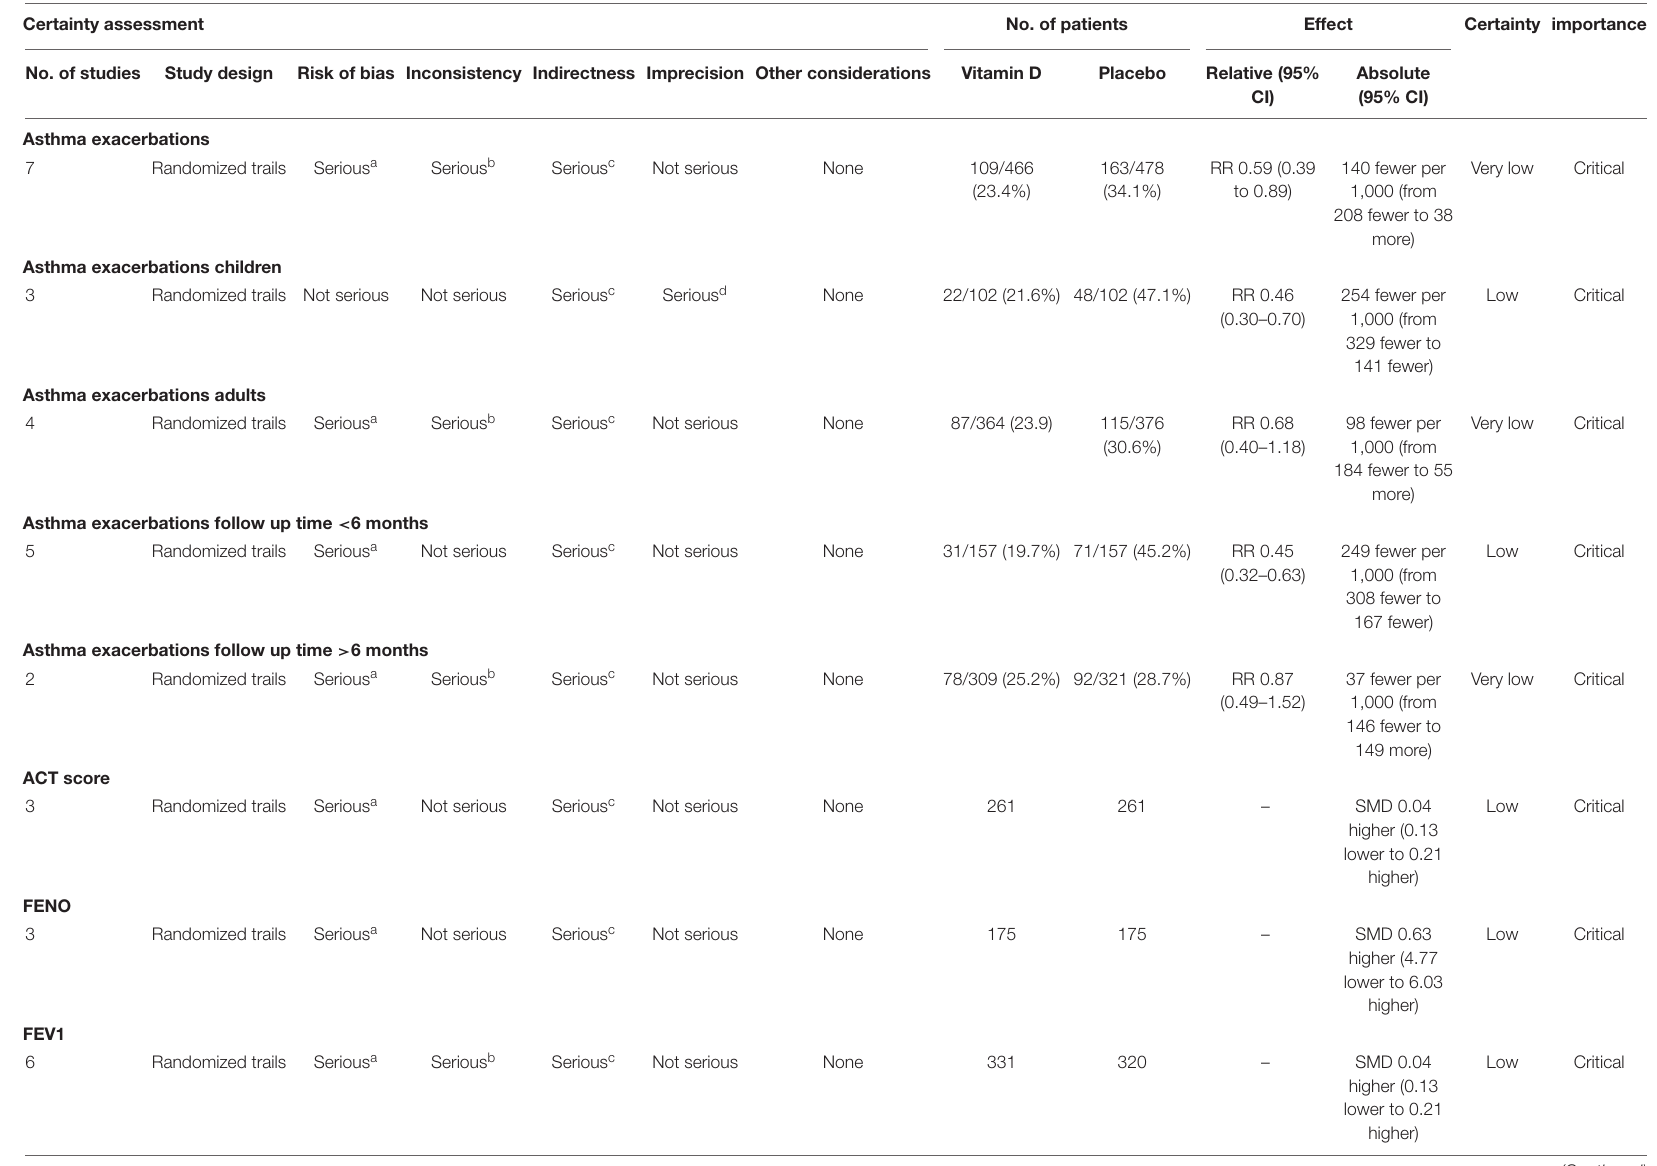
TABLE 3 | The overall rating for the quality of evidence profile for asthma related health outcomes based on the grading of Recommendations Assessment, Development, and Evaluation (GRADE) Working group methodology. Certainty assessment No. of patients Effect Certainty